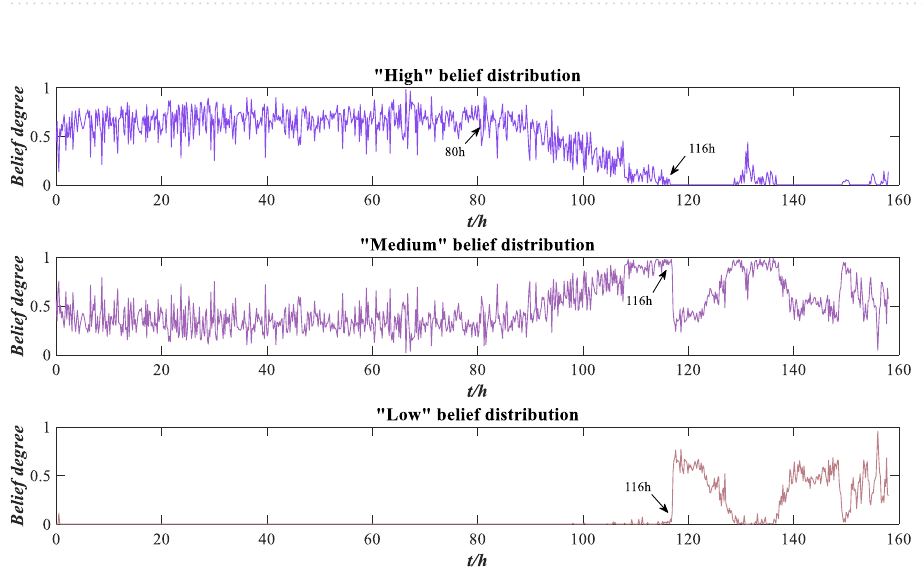
Figure 6. Performance evaluation results of rolling